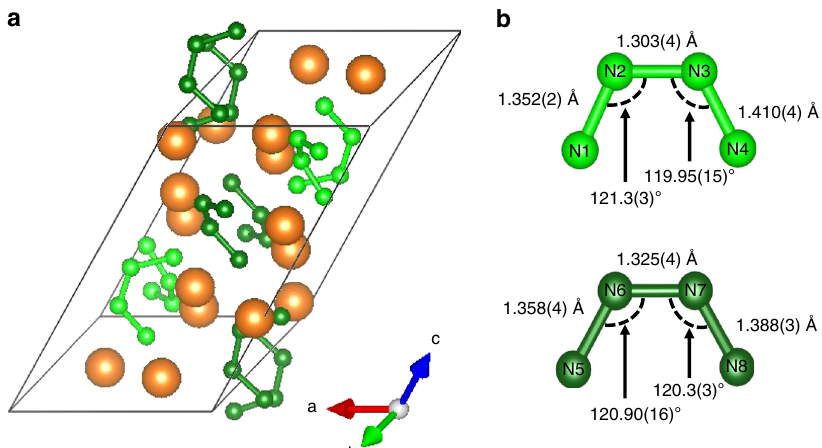
Fig. 4 Crystal structure of the α -Mg 2 N 4 salt at ambient conditions. a The unit cell of α -Mg 2 N 4 (see also Supplementary Fig. 16). b The bond lengths and angles in the two distinct N 4 4 − entities: the a ’ -N 4 4 − (light green, top) and b ’ -N 4 4 − (dark green, bottom). The orange and green spheres represent Mg and N